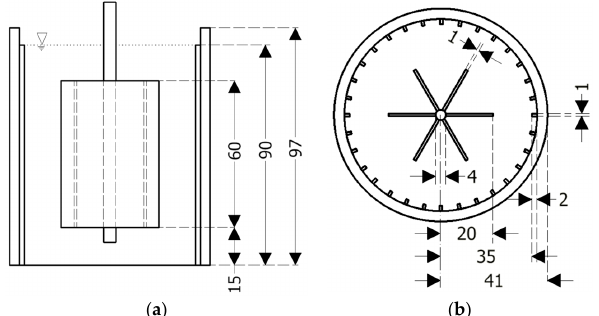
Figure 1. Scheme of the vane-in-cup rheometer setup with 24 vertical lamellae fixed at the outer stationary cylinder and a six-blade vane rotor; ( a ) vertical cut, ( b ) top view; all dimensions in mm.